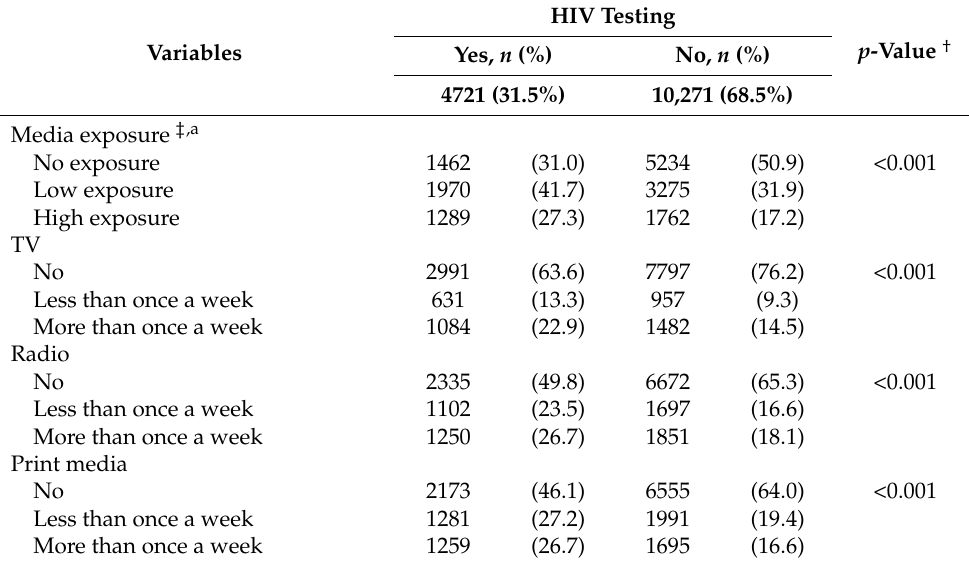
Table 3. Relationship between media exposure and HIV testing in the study participants.